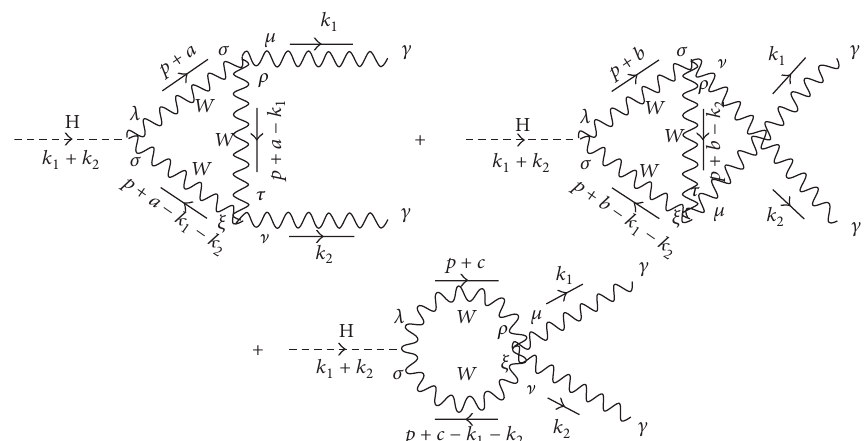
Figure 1: 𝑊 -gauge boson contribution to the 𝐻 → 𝛾𝛾 amplitude. Momentum flow together with relevant shift vectors is indicated.